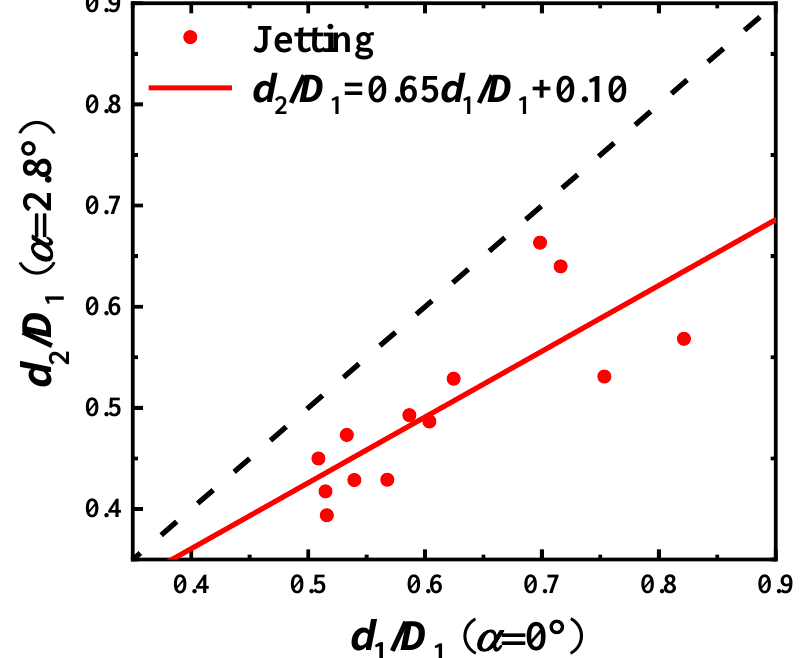
Figure 11. The correlation test of the paraffin droplet sizes between d 1 in the Jetting